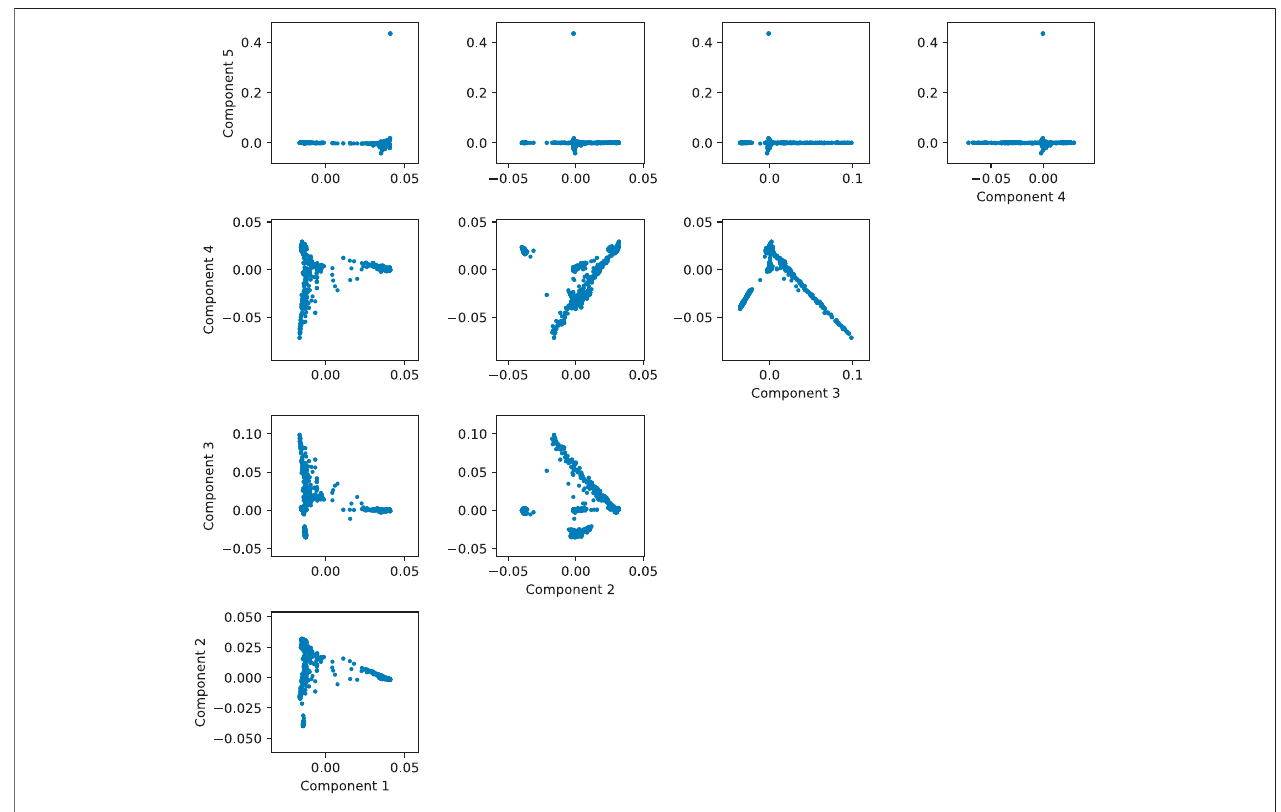
FIGURE 9 | Matrix of scatterplots between the fi rst fi ve principal components of simulated data based on 1,000 Genomes.